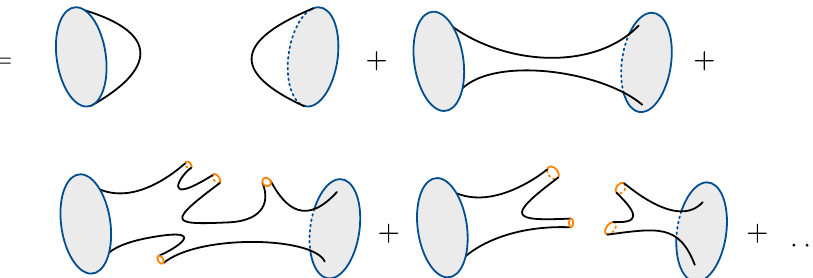
qy in our gravity theory deformed by the ex- q Z p β Figure 8: Contributions to x Z p β 1 2 ternal field H . The blue boundaries are asymptotic boundaries, whereas the orange 0 ones are boundaries come from the ghost branes and are labelled by the eigenvalues of H (not explicitly drawn 0